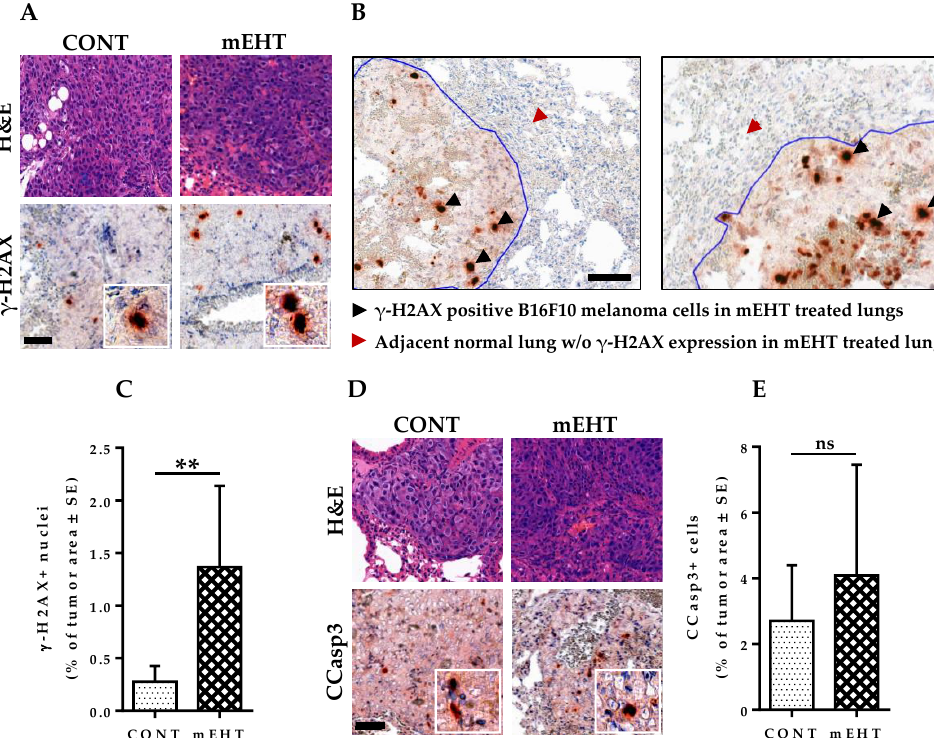
Figure 6. mEHT induced DNA damage response in metastatic B16F10 melanoma. ( A ) H&E and γ -H2AX staining of mouse lungs in CONT and mEHT; ( B ) Image depicting DNA damage response to mEHT treatment in tumor area but not in adjacent normal lung tissue; ( C ) Plot of γ -H2AX-positive nuclei as a percentage of total tumor area in CONT ( n = 6) and mEHT ( n = 7); ( D ) H&E and CCasp3 staining of mouse lungs in CONT and mEHT; ( E ) Plot of CCasp3-positive cells as a percentage of total tumor area in CONT ( n = 12) and mEHT ( n = 9). Data represent average ± SEM. ( C , E ) CONT vs. mEHT, unpaired t -test, ns = non-significant, ** p < 0.01. Scale bar on ( A , D ) represents 50 µ m on all low-power images and 15 µ m in their insets and 50 µ m on ( B